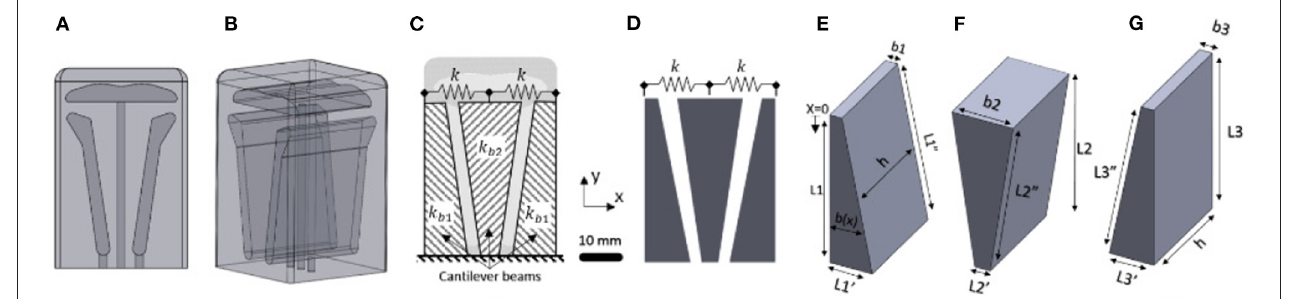
FIGURE 1 | 3D model of the soft robotic actuator in (A) front view and (B) orthogonal view. (C) Model of the actuator specifying the naming convention for the cantilevered beams. (D) Schematic of cantilever model of the actuator considering the spring in between. (E) Schematic of the first cantilever model of the actuator. (F) Schematic of second cantilever model of the actuator. (G) Schematic of third cantilever model of the